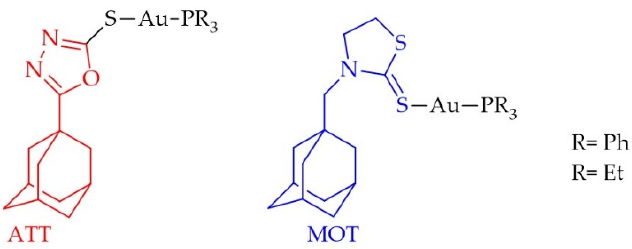
Figure 11. The Au(I) complexes with the sulfur coordinating groups 5-adamantyl-1,3-thiazolidine-2-thione (ATT) and 3-methyladamantane-1,3,4-oxadiazle-2-thione (MOT) and the phosphine ligands containing ethyl or phenyl substituents [104].